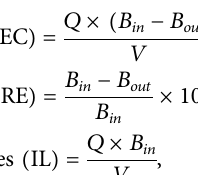
TABLE 1 | Experimental results based on central composite design. Run order Feed fl ow Initial substrate rate (ml/min) concentration (mg/L)